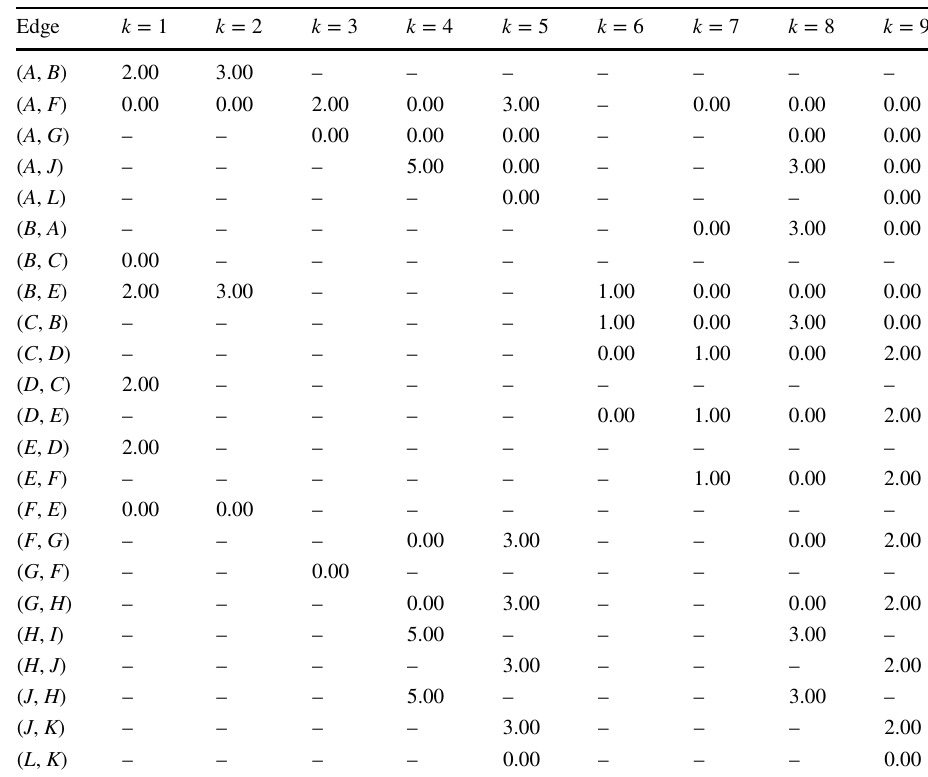
Table 11 Optimal solution for the Example